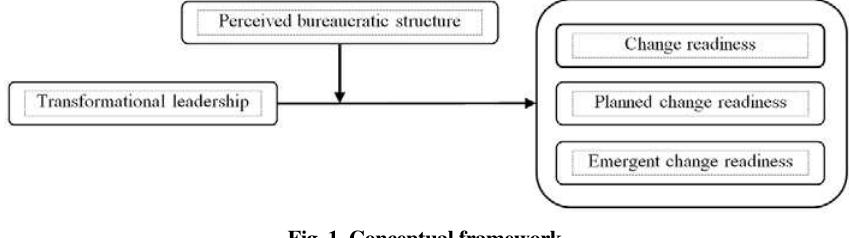
Fig. 1. Conceptual